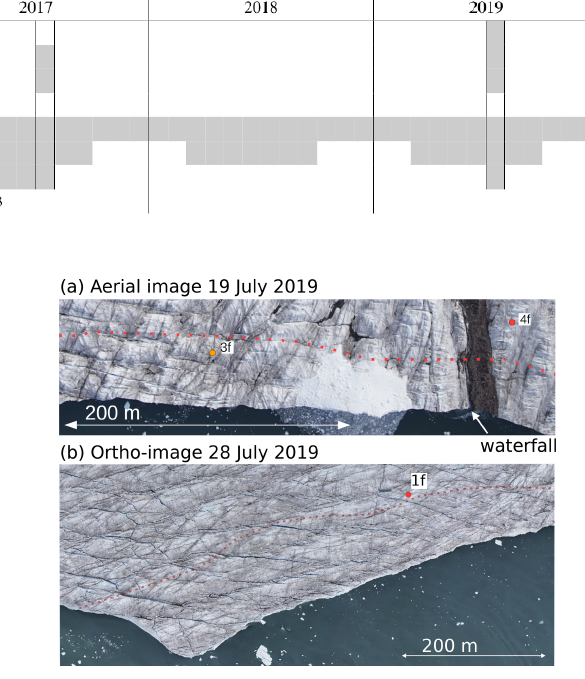
Figure 6. (a) UAV aerial image, taken on 19 July 2019, 17h before GPS station 3f calved off, but 4f did not calve. (b) Ortho-image on 28 July 2019, 14h prior to calving. The approximate locations of calving, derived from UAV and satellite imagery, are drawn as dotted red lines. The area of white ice fragments in (a) is discussed in Sect. 5.2. For reference, the location of station 1f at its retrieval on 25 July is shown in (b)